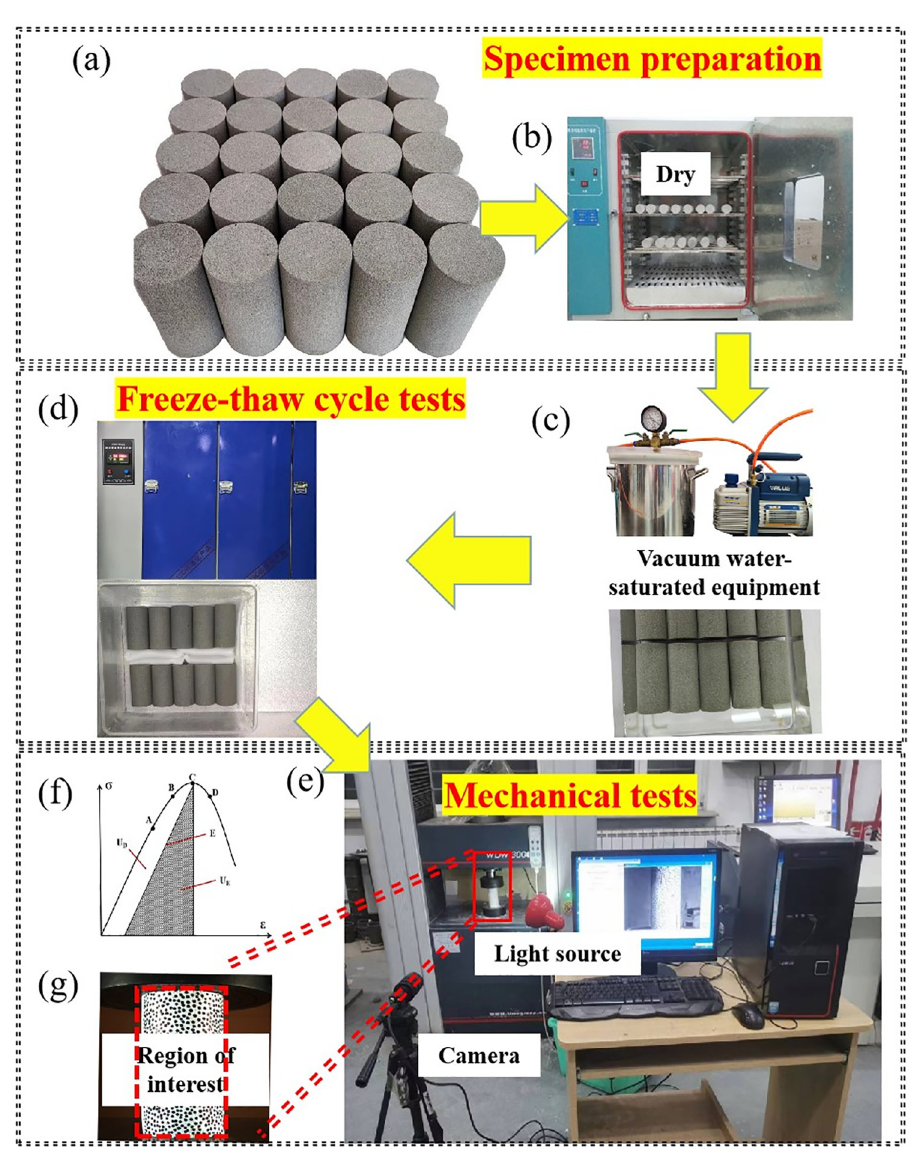
Fig 1. Test equipment and procedure. (a) Preparation of rock specimens (b) Electric drying oven (c) Vacuum water- saturation equipment (d) Freeze-thaw cycle equipment (e) Digital speckle and mechanical test (f) Energy evolution characteristics (g) Speckle